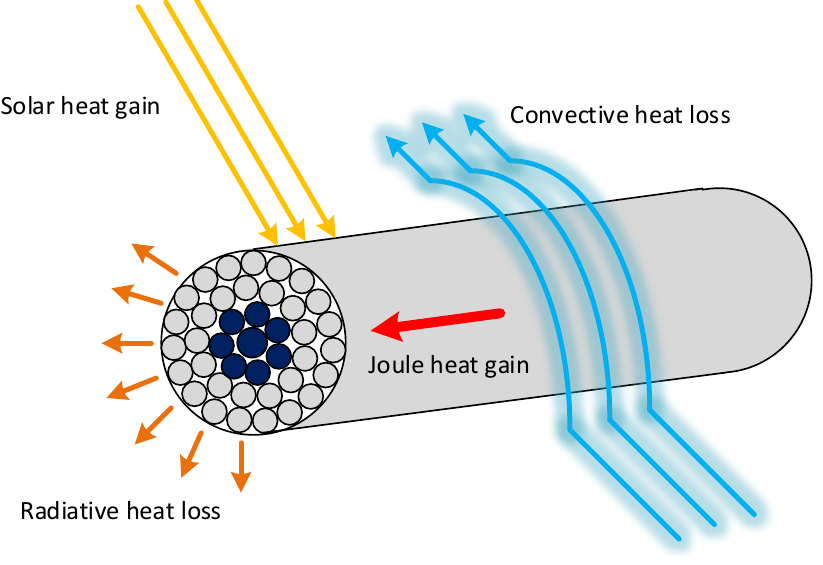
Figure 2. Heat balance of an overhead conductor.